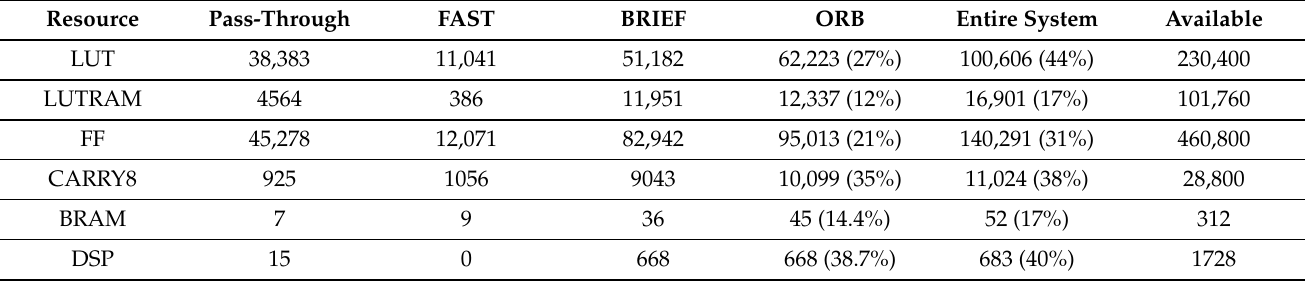
Table 2. Resource utilisation of our implementation. A significant part of the presented logical resources is consumed by the video pass-through. The high utilisation of DSP blocks is related to the use of the Gaussian filter and the IC module (which performs multiplications for the circular patches from the four contexts of 31 × 31